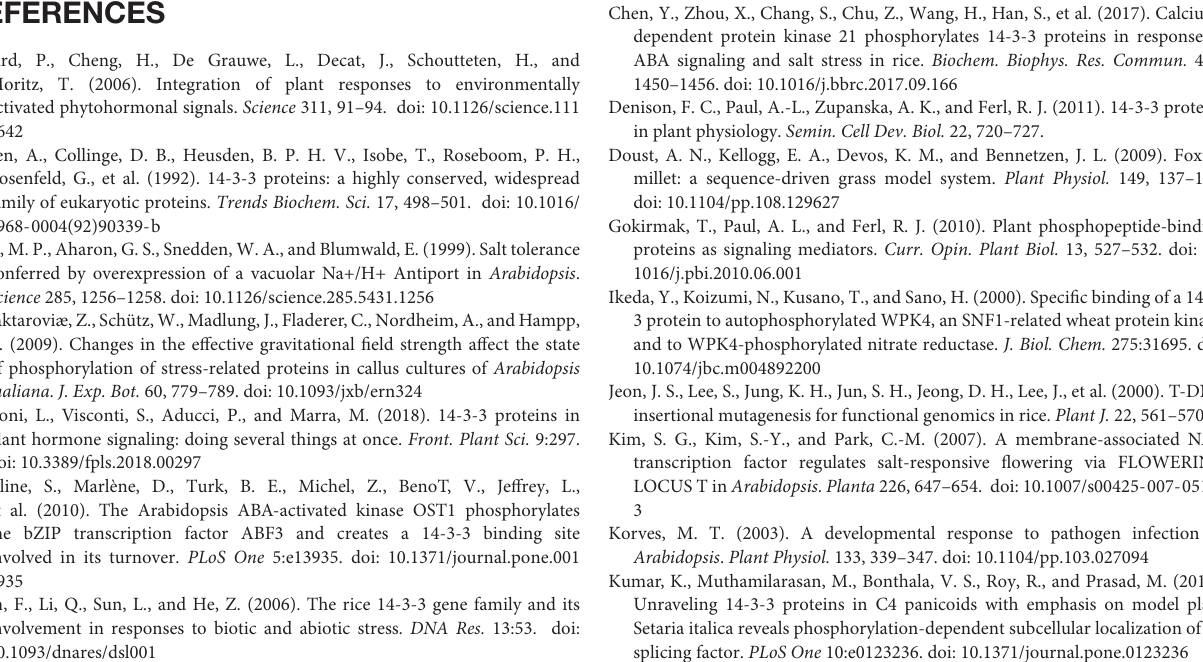
FIGURE S3 | Phenotypic comparison of root lengths of SiGRF1 -OE, SiGRF2 -OE, SiGRF3 -OE, and SiGRF4 -OE plants grown on MS medium with or without treatment of 120 mM NaCl, 6% PEG, or 0.5 µ M ABA. (A) Images were recorded on day 5 after the transfer of 5-day-old seedlings from 1/2 MS medium to plates containing 120 mM NaCl, 6% PEG, or 0.5 µ M ABA, White solid line indicates that plants promote root growth. Bars = 1 cm. (B,C) Effect of different stress treatments on root growth in Col-0 and transgenic plants. Data represent means ± SD ( n = 30). Students t -tests were used to generate the P -values. * P < 0.05; ** P < 0.01. FIGURE S4 | Phenotypic comparison of root lengths of SiGRF5 -OEs, SiGRF6 -OEs, SiGRF7 -OEs, and SiGRF8 -OEs plants grown on MS medium with or without treatment of 120 mM NaCl, 6% PEG, or 0.5 µ M ABA. (A) Images were recorded on day 5 after the transfer of 5-day-old seedlings from 1/2 MS medium to plates containing 120 mM NaCl, 6% PEG, or 0.5 µ M ABA, White solid line indicates that plants promote root growth. Bars = 1 cm. (B,C) Effect of different stress treatments on root growth in Col-0 and transgenic plants. Data represent means ± SD ( n = 30). Students t -tests were used to generate the P -values. * P < 0.05; ** P < 0.01. TABLE S1 | SiGRFs and SiRNF1/2 in foxtail millet. Detailed genomic information including domain/class, alias, ORF length, protein length, genomic locus (chromosomal location), number of introns within ORF, subcellular localization, isoelectric point, and molecular weight (kDa). TABLE S2 | Characteristic features of 14-3-3 gene family members identified in seven species. TABLE S3 | The sequences of primers used in the study. The sequences shown in lower case were added to generate a restriction enzyme site. TABLE S4 | Average log signal values of SiGRF protein-encoding genes from three biological replicates of each sample. TABLE S5 | Average log signal values of SiGRF genes subjected to ammonia, drought, nitrate, urea, dark, blue, red, and far red light treatments. TABLE S6 | RNA-Seq analysis of gene expression associated with SiGRF1 action. Total RNA isolated from 2-week-old seedlings, comparing SiGRF1-OE line 1 plants to Col-0